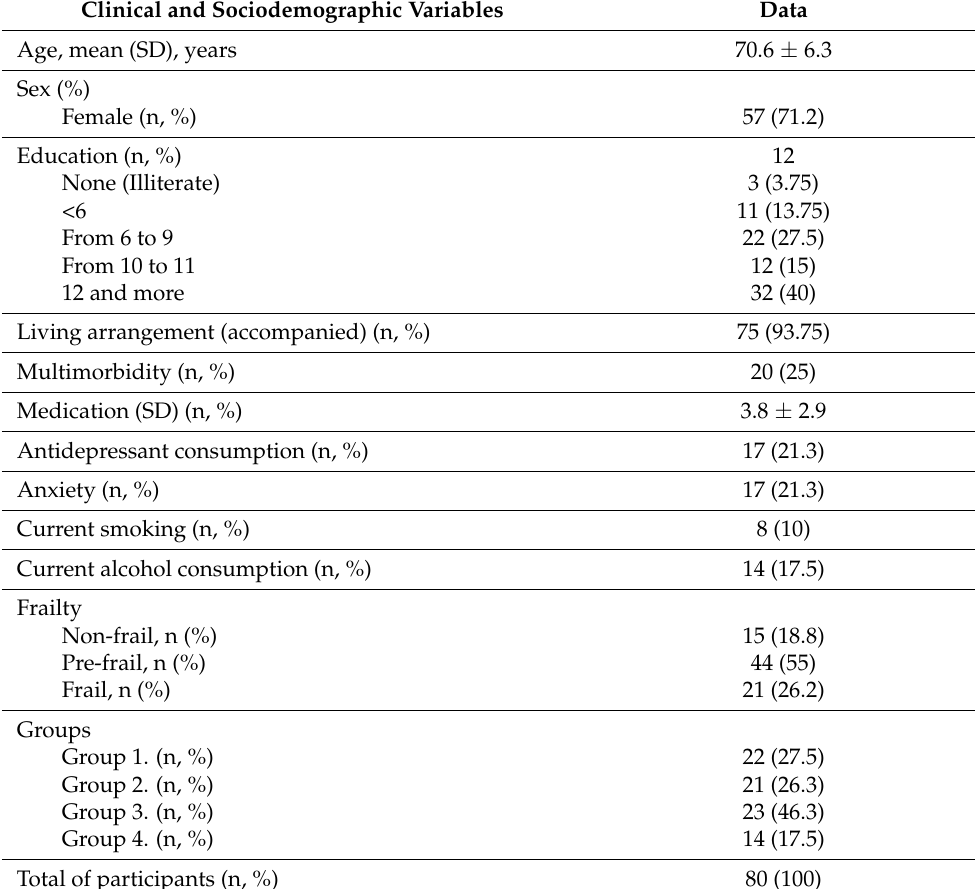
Table 1. Characteristics of the study